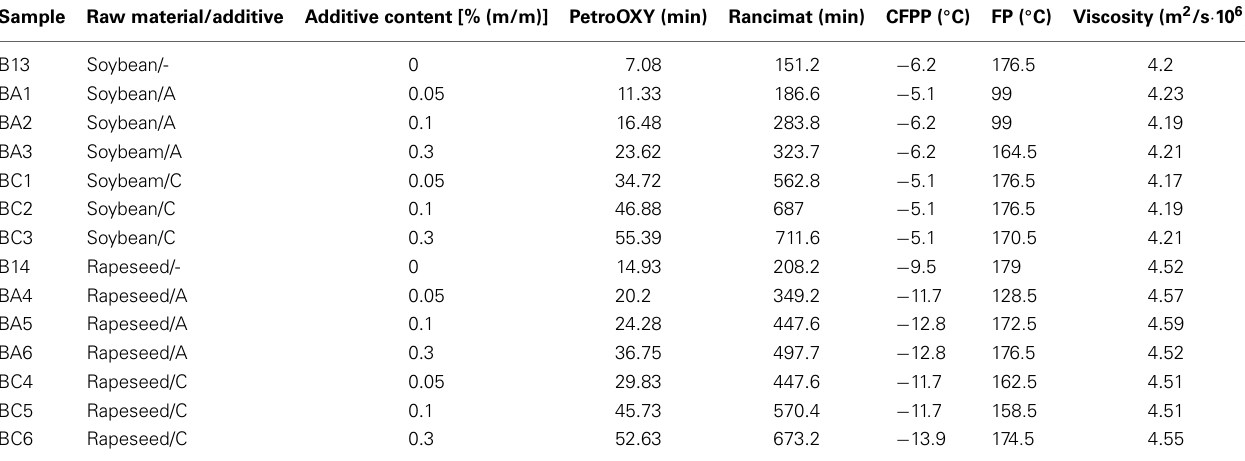
Table 4 | Physicochemical properties of the biodiesel blends with additives: Results for 4-allyl-2,6-dimethoxyphenol (A) and catechol (C), blended with soybean and rapeseed biodiesel.